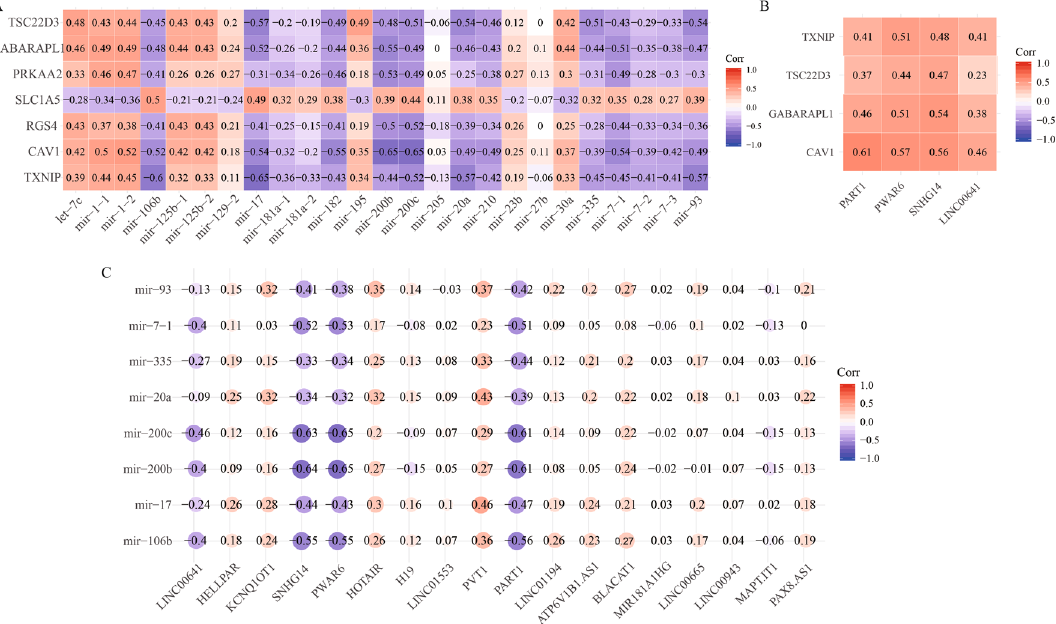
(Fig.S2). These data suggested that the four key ferroptosis-related genes are regulated by four key lncRNAs and six key miRNAs, thereby affecting ferroptosis in gastric cancer.